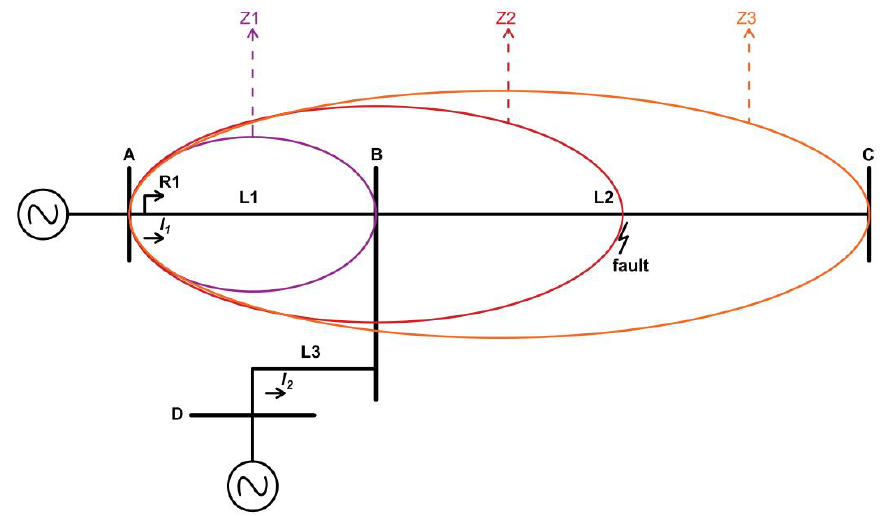
Figure 4. Infeed conditions on the transmission